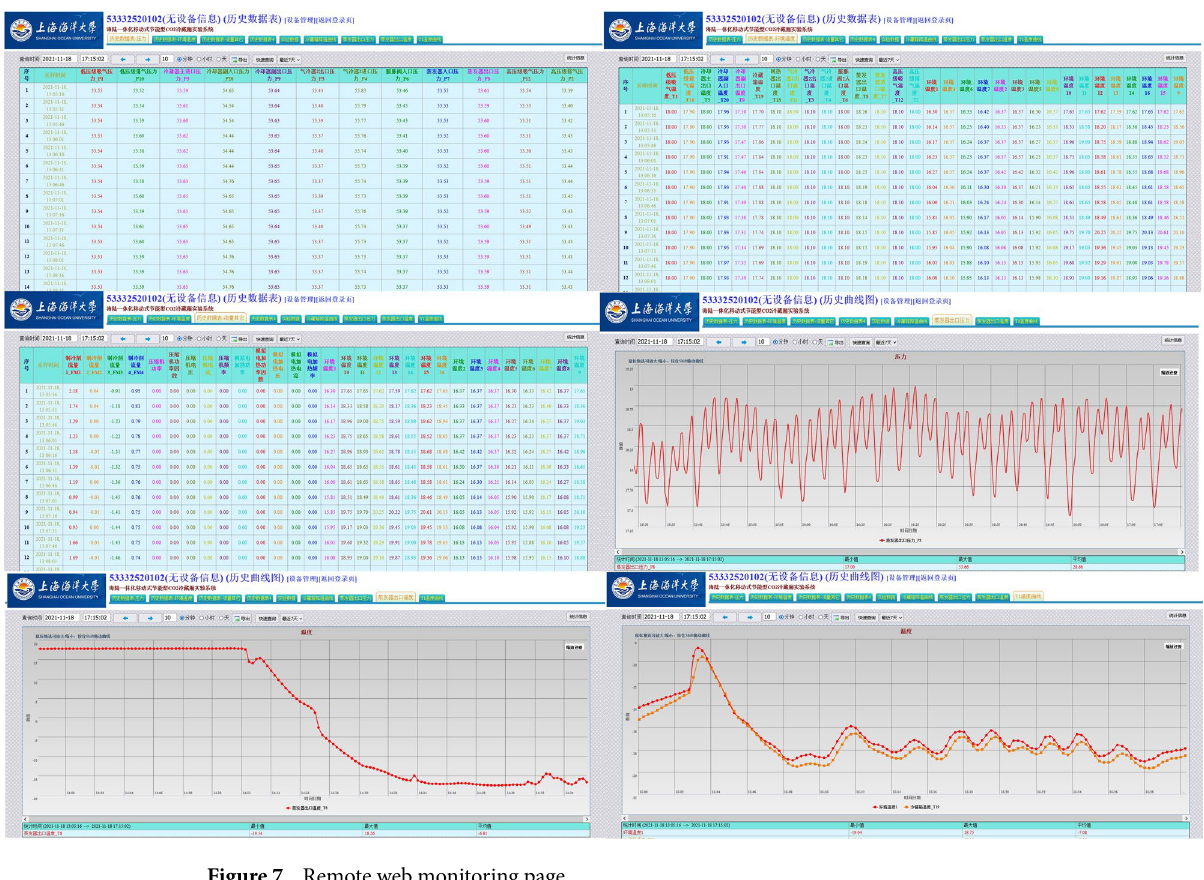
Figure 7. Remote web monitoring page.